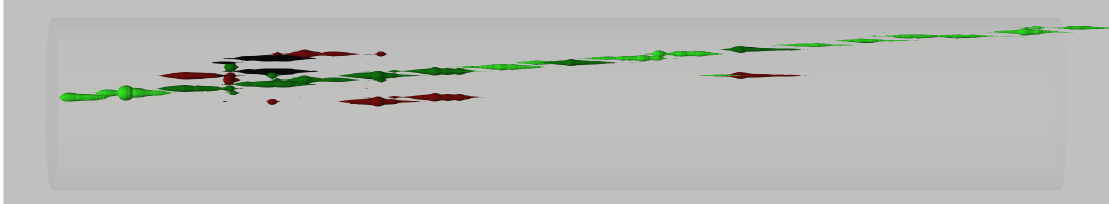
Figure 9. Reconstructed 3D hits from the hit finder. Axes are the same as in Figure 10. The passing particle is most likely a cosmic µ entering from the left (the same event as in Figures 6–8, and 10). Drift direction is from right to left. The shapes of the hits encode the shapes of the corresponding pixel pulses. Each signal sample is represented by a sphere with its radius proportional to the signal amplitude, resulting in a drop